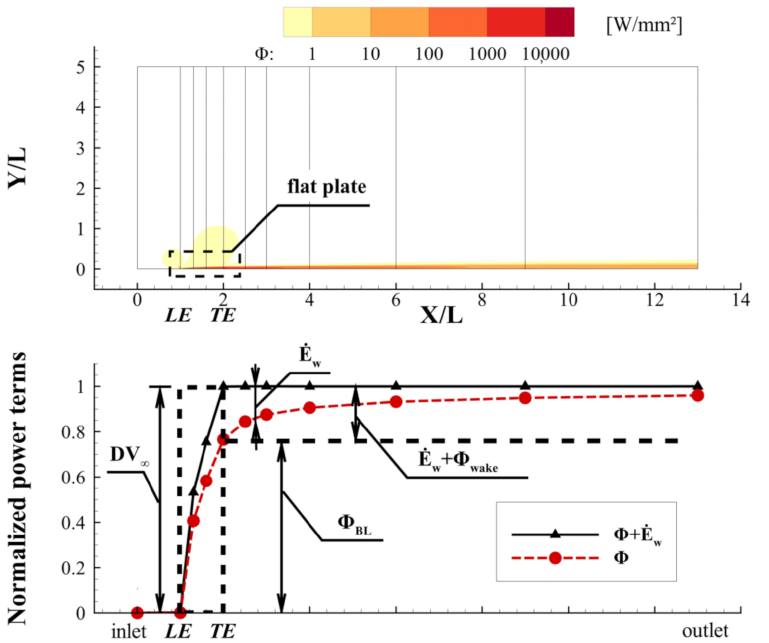
Figure 9. Contours of the integrand of viscous dissipation ( top ) and the power bookkeeping of a flat plate ( bottom )